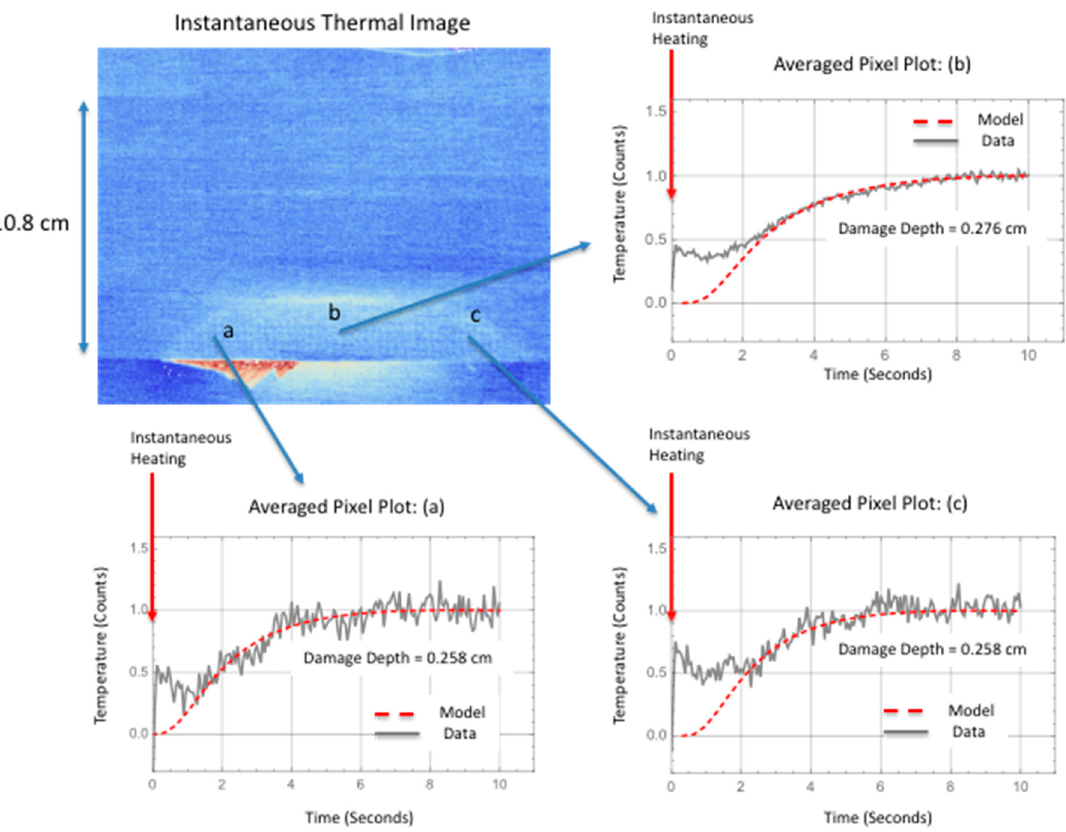
Figure 18. Two-dimensional simulation comparison to surface temperature response as a function of time for a flaw source buried at 0.276 cm.